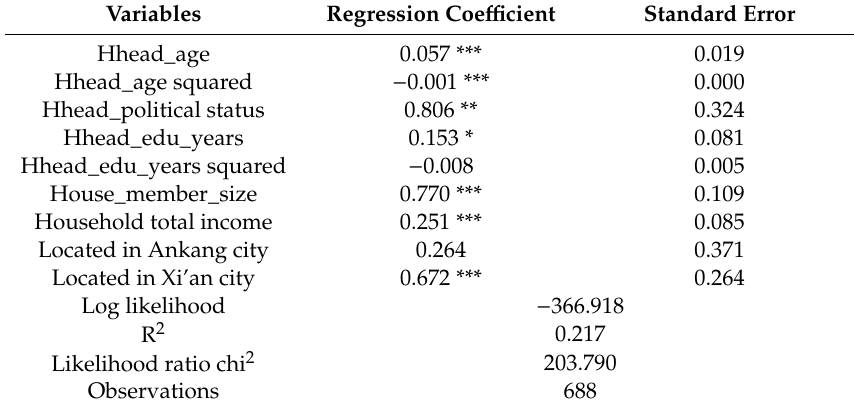
Table 2. Estimation results for farmer participation in formal lending equation based on the Logit model.